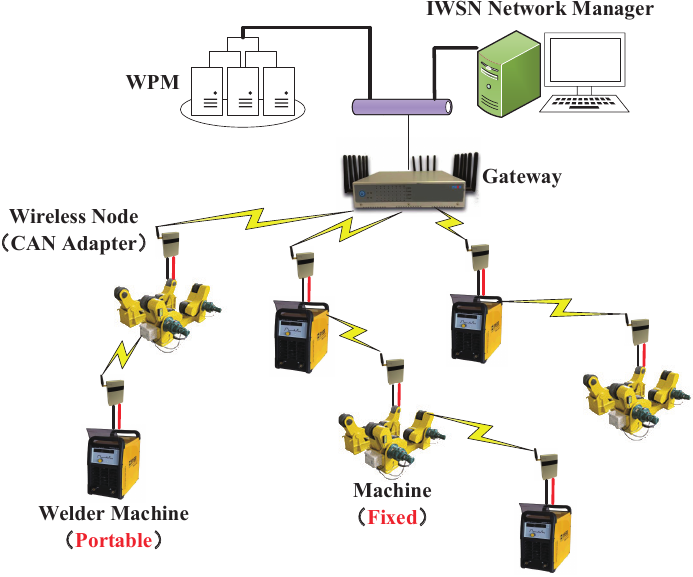
Figure 1. The WirelessCAN system prototype including fixed and portable